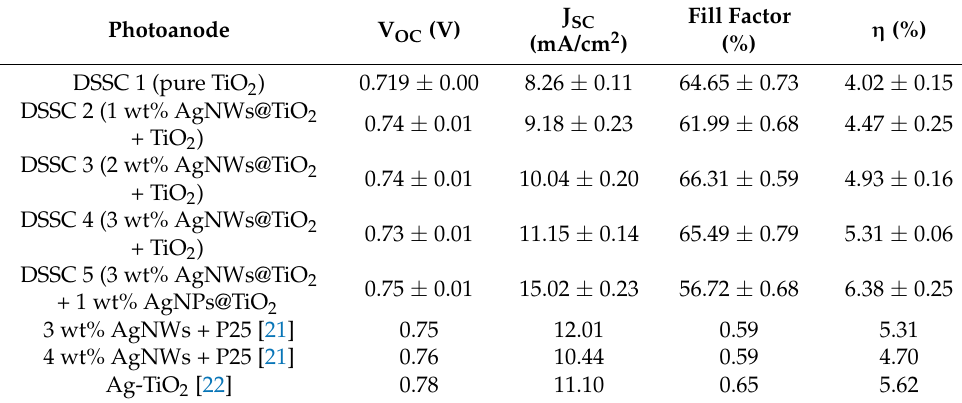
Table 1. Photovoltaic parameters of different photoanodes.